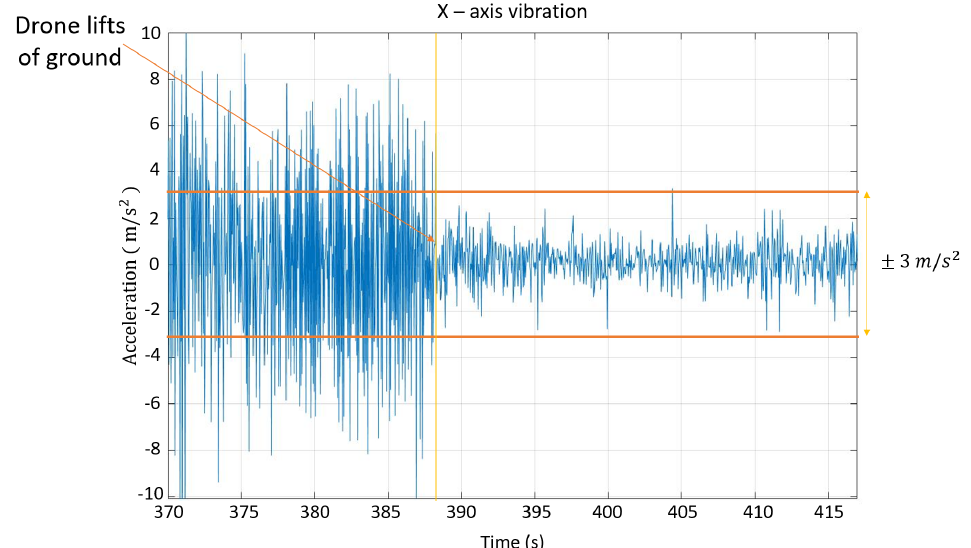
Figure 6. X-axis engine vibrations. When the drone lifts off the ground, the vibrations reduce to be within the acceptable range for the flight